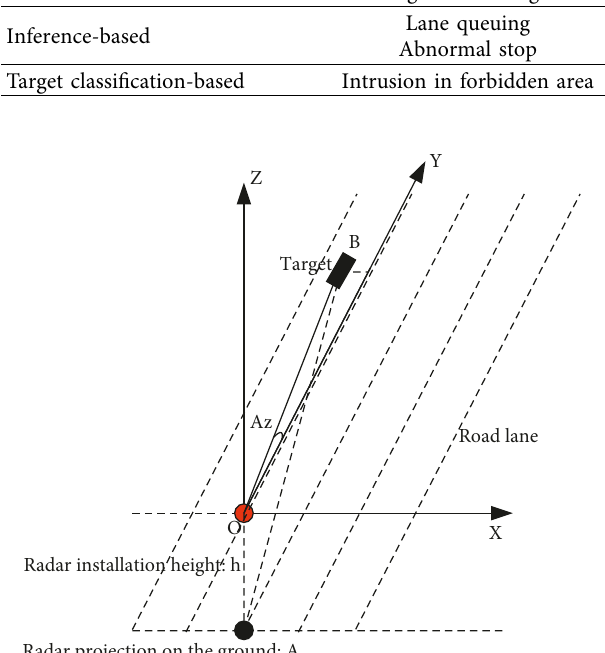
Figure 3: Schematic diagram of radar installation position.